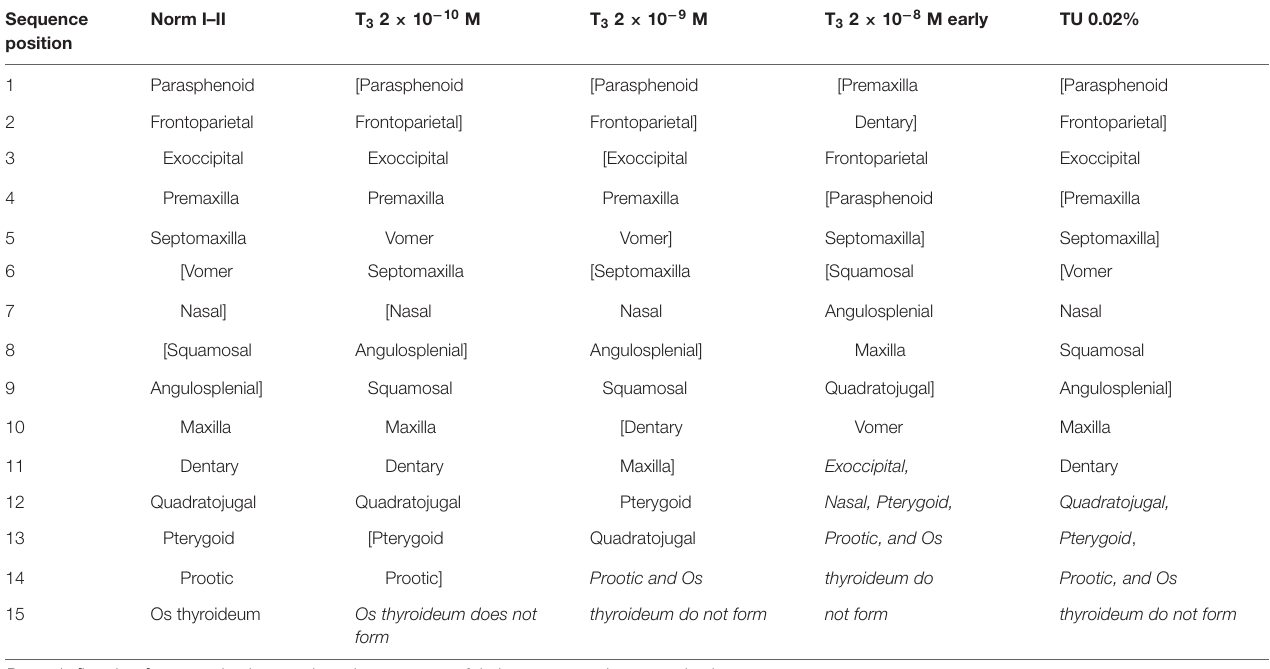
Bones in [brackets] appear simultaneously or the sequence of their appearance is not resolved.